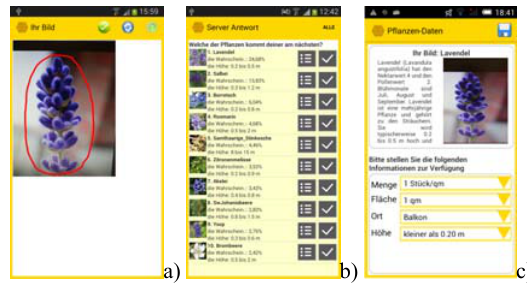
Figure 12: a) Manal segmentation by describing a polygon around the plant on the touch screen, b) App-server response with a sorted list of probabilities, c) Provision of meta-data by manual selection or input (Source: Shohrab